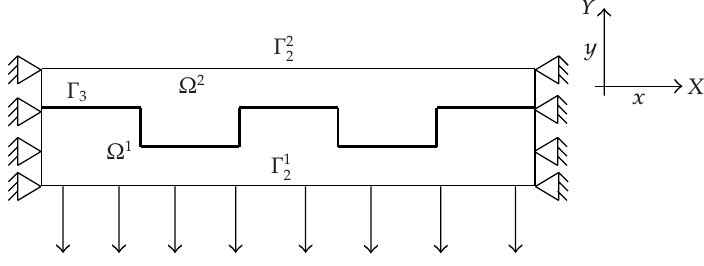
Figure 6.8 . Initial configuration in the second two-dimensional example.